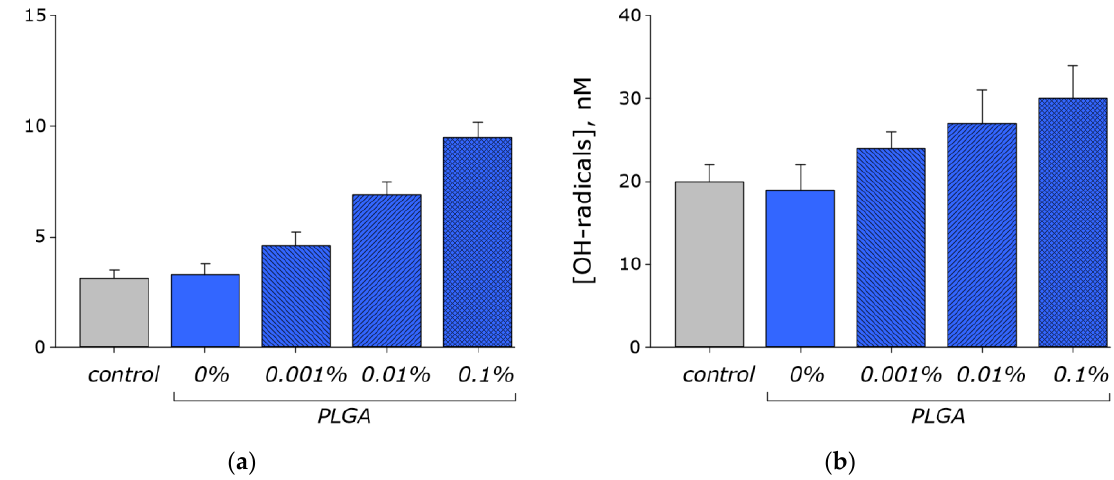
Figure 7. Effect of composite material containing PLGA and Al 2 O 3 NPs on the generation of reactive oxygen species: ( a ) Generation of H 2 O 2 (2 h, 40 °C); ( b ) Generation of OH-radicals (2 h, 80 °C); Data are presented as mean values and standard errors of mean.